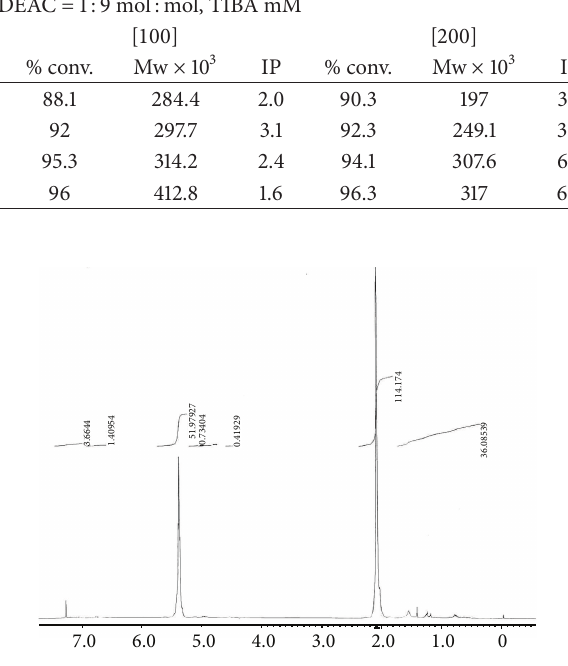
Figure 3: Spectrum 1 H NMR of high cis -1,4-BR synthesized with 200